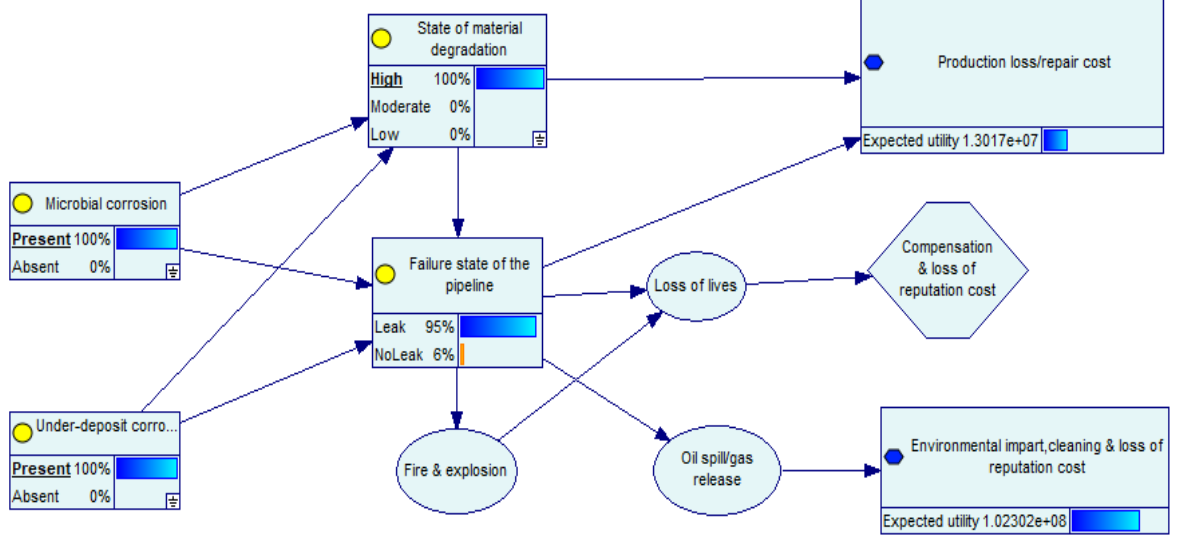
Figure 4. Impact of complex interaction on the failure state and the predicted economic